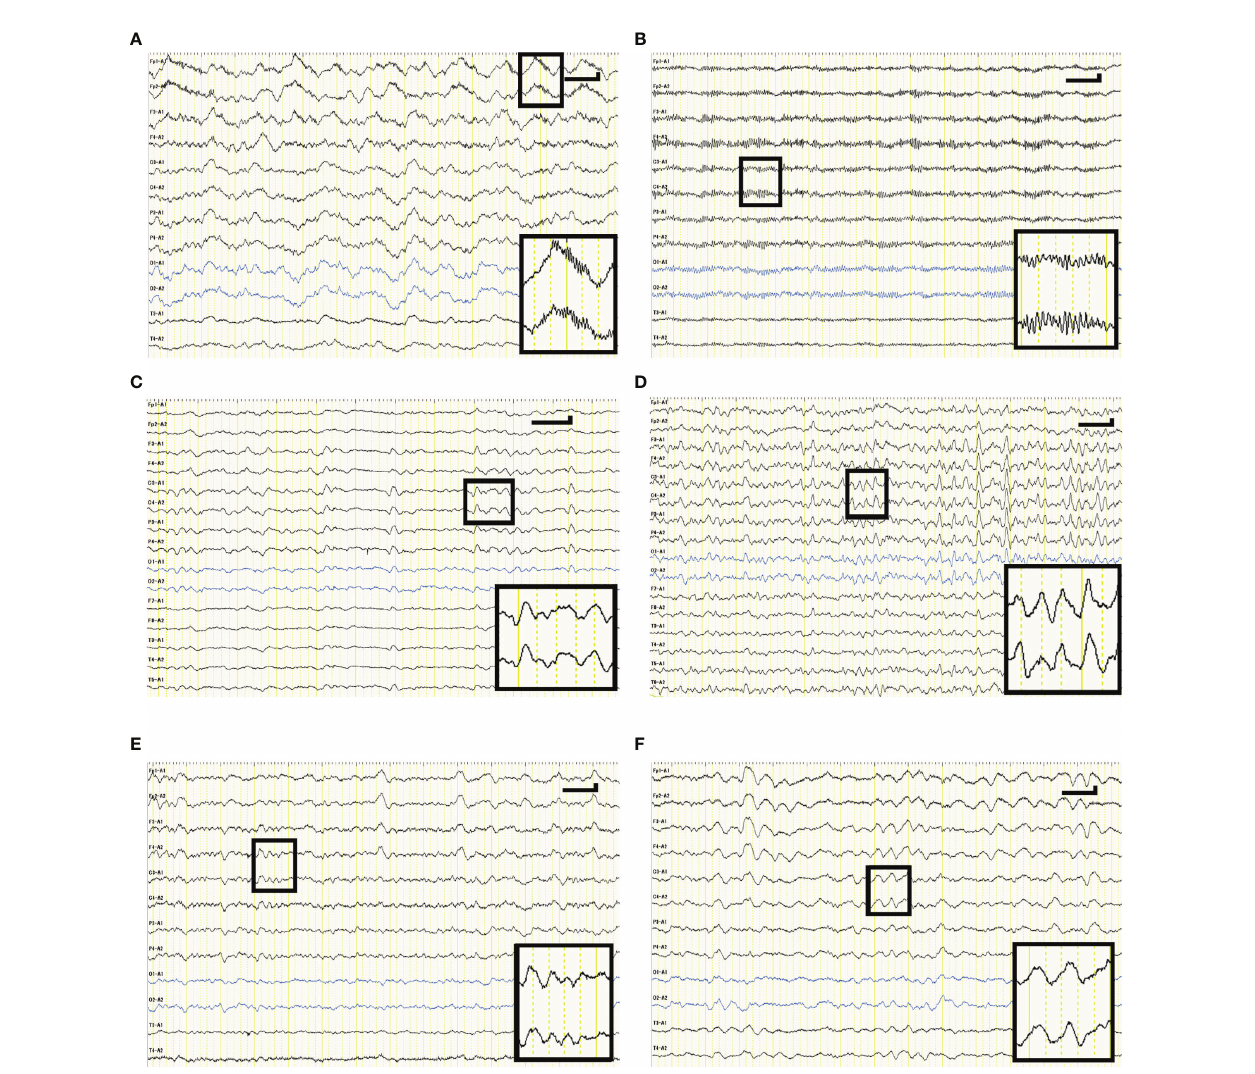
FIGURE 2 | Representative EEG waveforms of cases with NMDARE (A, B) , de fi nite autoimmune encephalitis (C, D) , ADEM (E) , and LE (F) . (A) shows extreme delta brush consisting of rhythmic beta activity upon rhythmic delta activity — a waveform speci fi c to patients with severe NMDARE — observed in case 1 in NMDARE group. (B) shows excessive beta activity observed in case 6 in the NMDARE group. (C) shows background slowing and intermittent rhythmic delta activity observed in case 5 of the other AEs group. (D) shows background slowing and generalized rhythmic delta activity observed in case 6 of the other AEs group. (E) shows background slowing whose frequency was 3 – 5 Hz observed in case 7 of the other AEs group. (F) shows frontal intermittent rhythmic delta activity observed in case 9 of the other AEs group. Vertical and horizontal bars in each panel indicate 50 µV and 1 s, respectively. ADEM, acute disseminated encephalomyelitis; LE, limbic